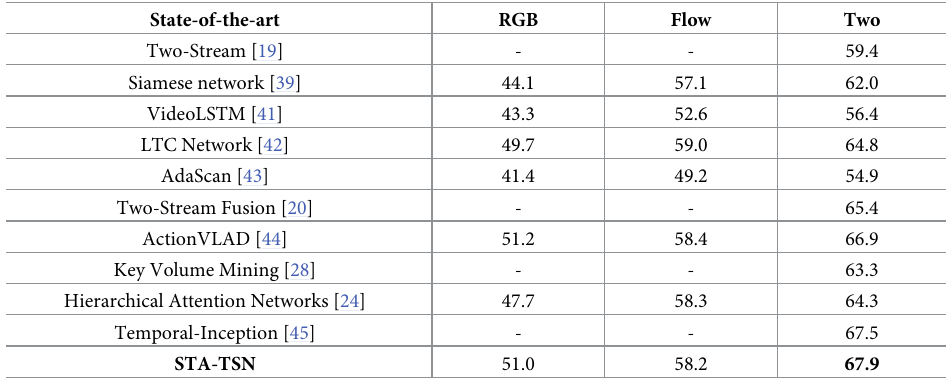
Table 5. Comparison with the state-of-the-art on HMDB51 (average over three splits). State-of-the-art